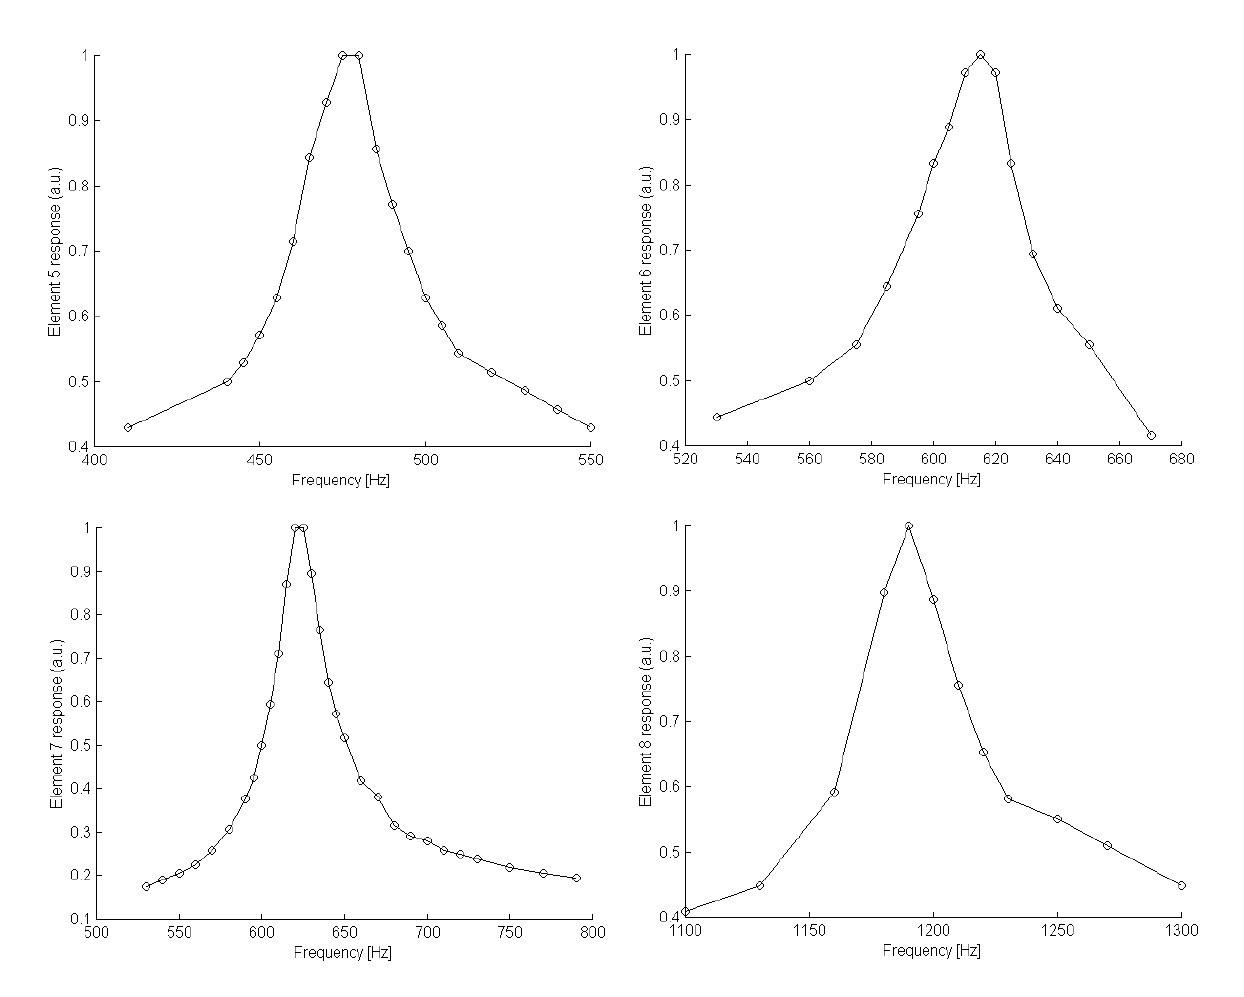
Figure 12. Resonance curves of No5, No6, No7 and No8 tested